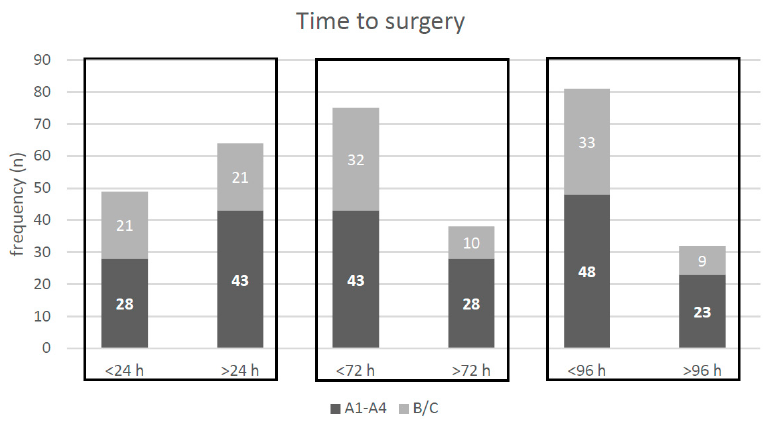
Figure 3. Distribution of the time to surgery related to three defined time points: 24, 72, and 96 h. Table 2. Regression analysis for time to surgery (dependent variable: > 24 h). Regression Coe ffi cient p -Value OR 95% CI − 0.007